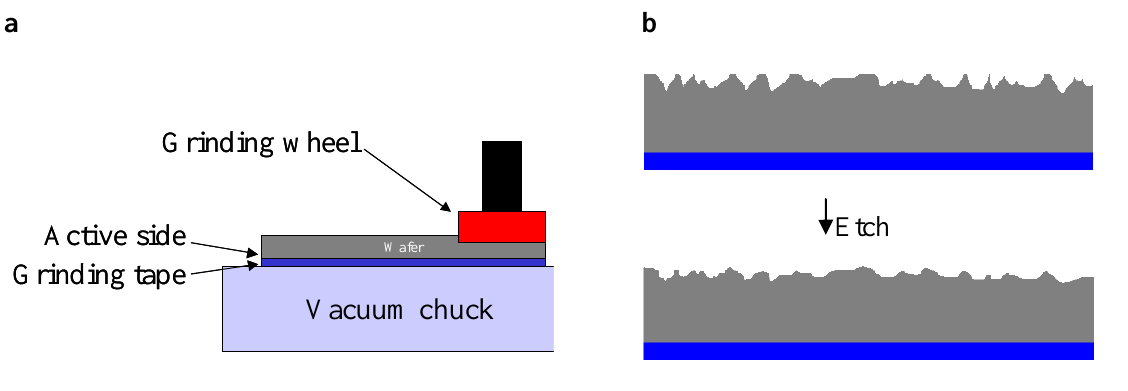
Figure 3. (a) Wafer thinning by grinding; (b) Etching away of crack initiation points in